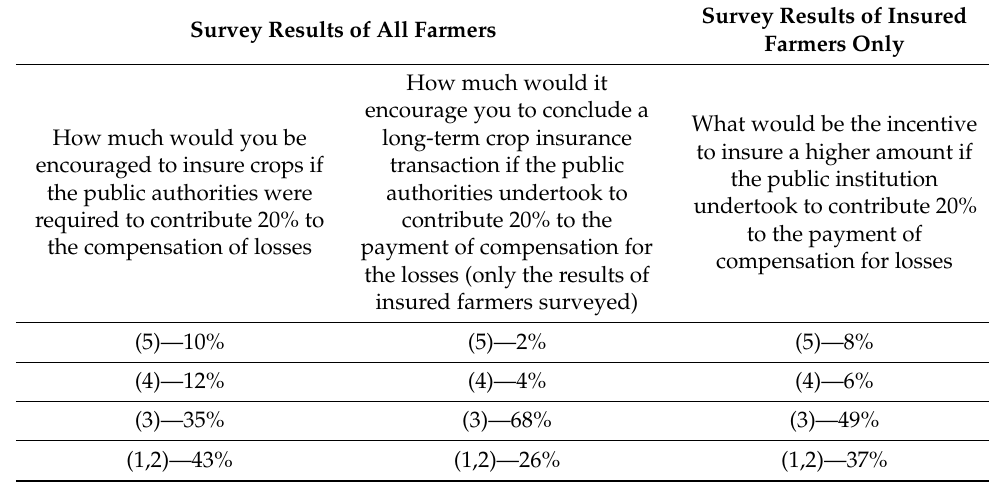
Table 2. Farmers’ views on the state’s contribution partial compensation of the losses.